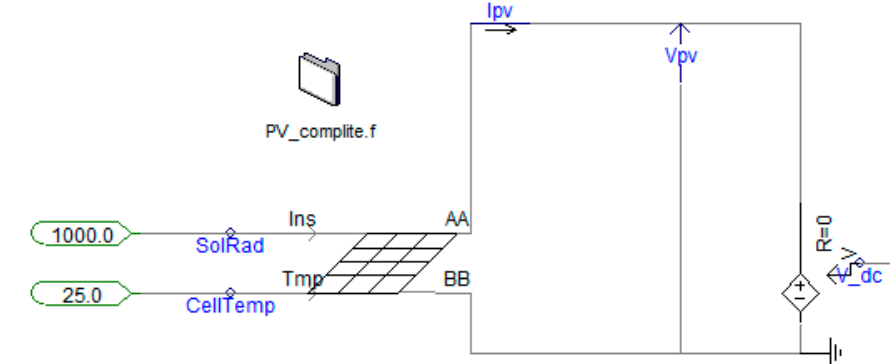
Figure 7. The test circuit of the PV array.